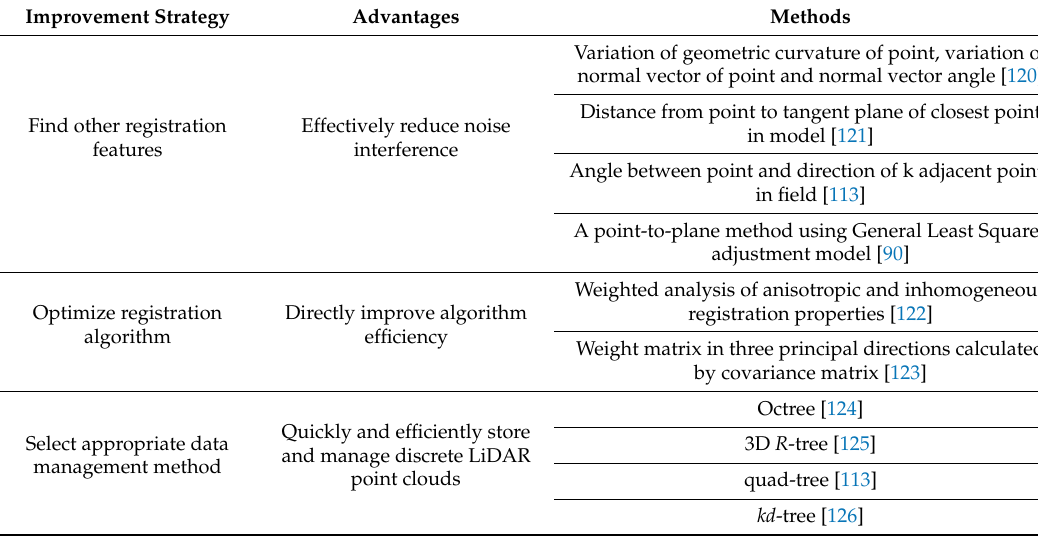
Table 5. Improved methods based on